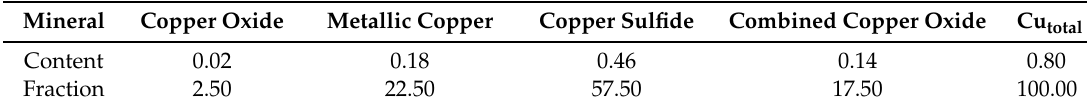
Table 3. The distribution of copper in associated minerals (wt. %).